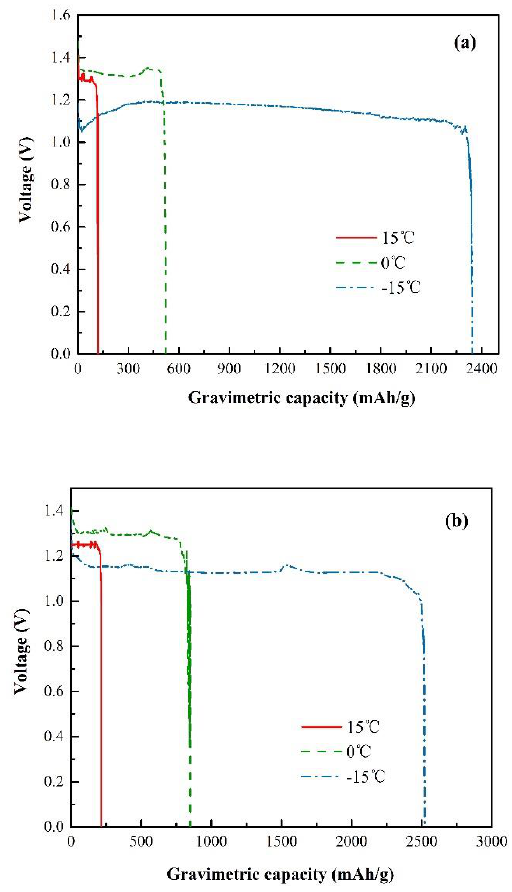
Figure 4. Discharging voltage profiles with a constant current density of 0.5 mA cm −2 : ( a ) and 1.0 mA cm −2 ; ( b ) by using 25 wt% KOH.